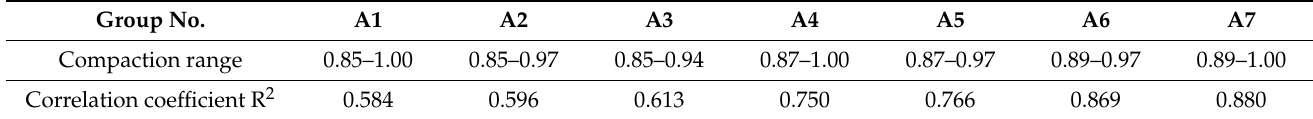
Table 3. Correlation coefficients of calibration equations for soil sample groups with different densities. Group